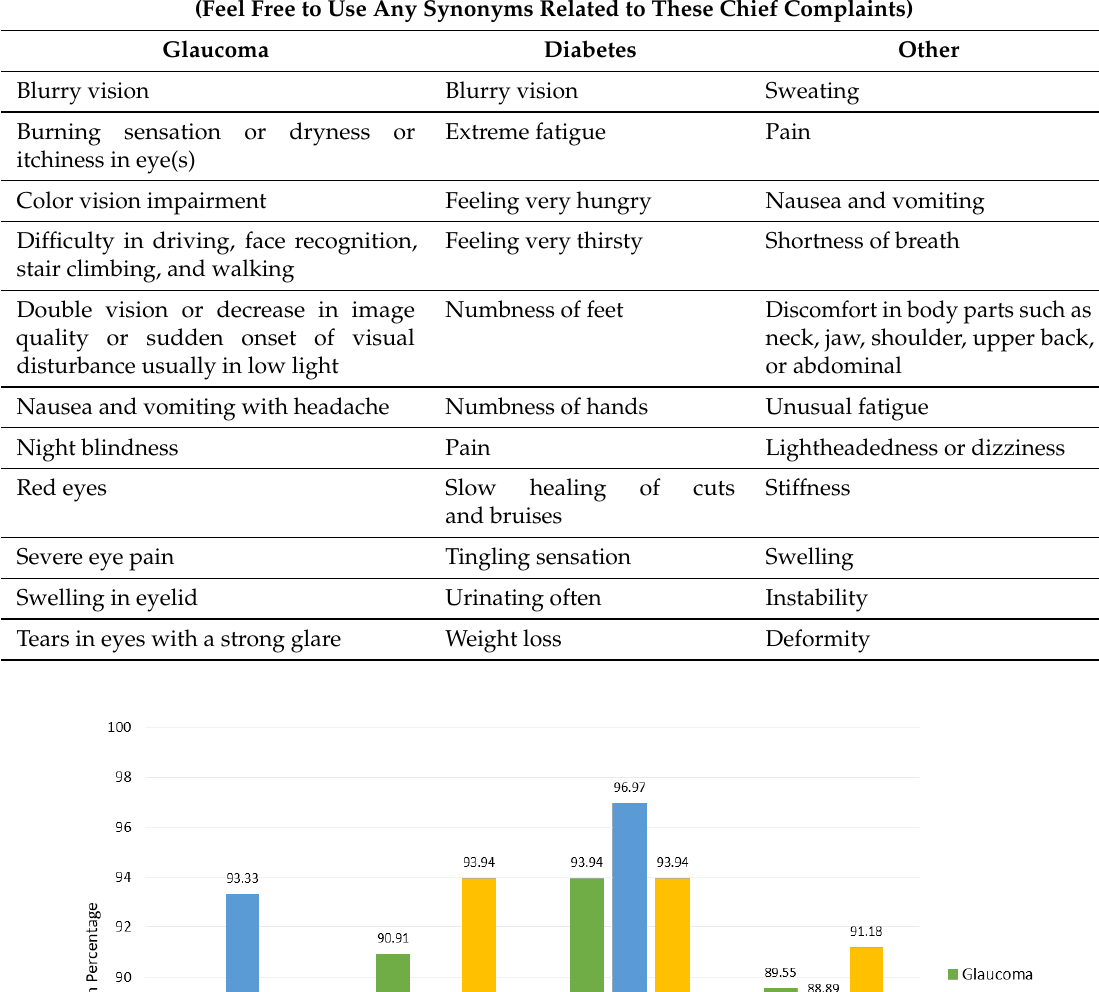
Table 3. Sample of hints for acting as glaucoma, diabetes, and other, patient types.